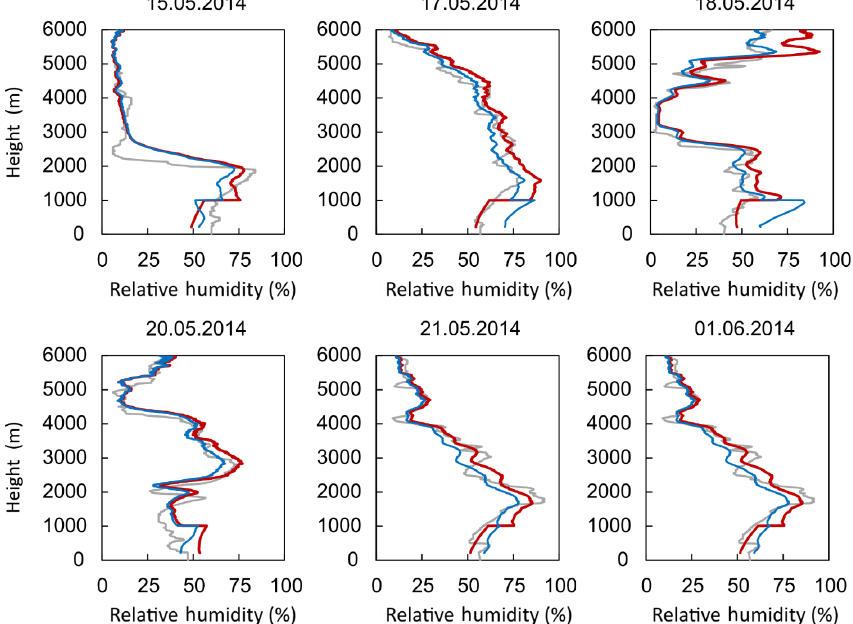
Figure 6. Vertical profiles of RH from combined methods for LD-WRF (blue) and LD-MWR (red) against high-resolution radiosoundings